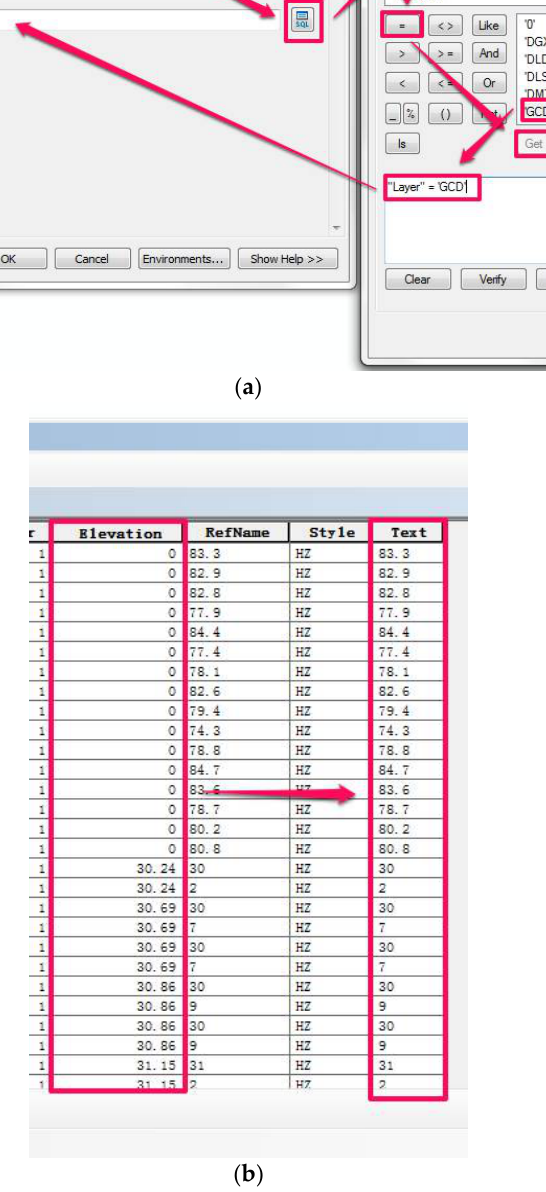
Figure 4. Elevation data extracted by the “Analysis-Extract-Select” tool in ArcToolbox ( a ) Produce to extract the elevation data; and, ( b ) The text field in the attribute table.